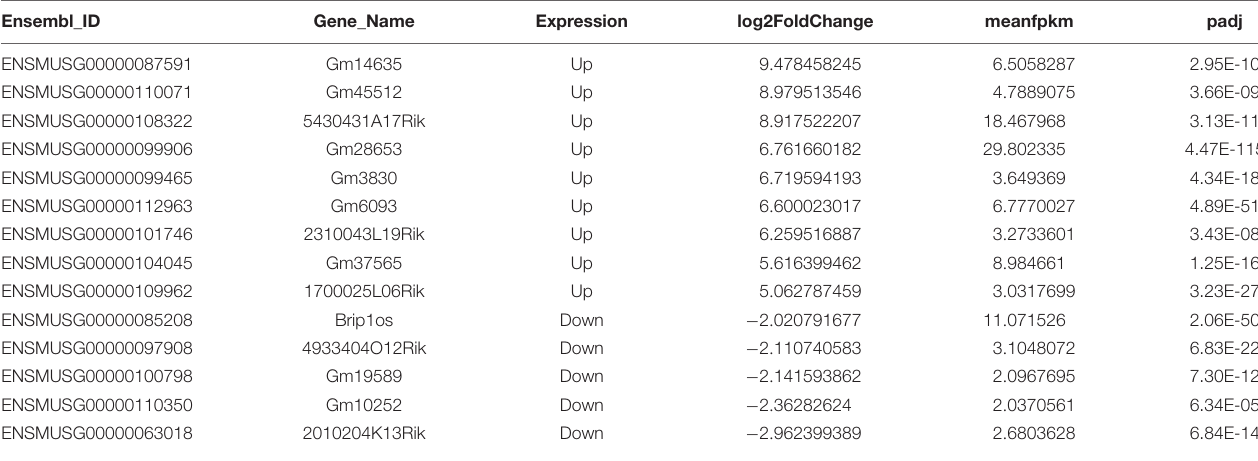
TABLE 1 | Top differentially expressed lncRNAs in myoblasts and differentiated